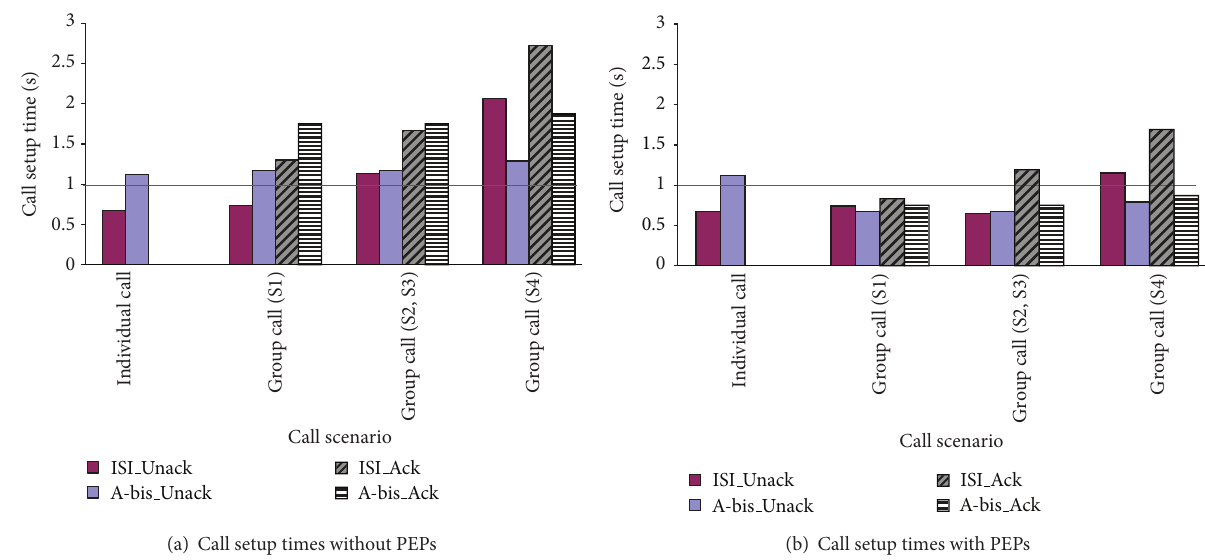
Figure 11: TETRA call setup times. Note: call setup time is considered to be the time between the call request and permission granted to